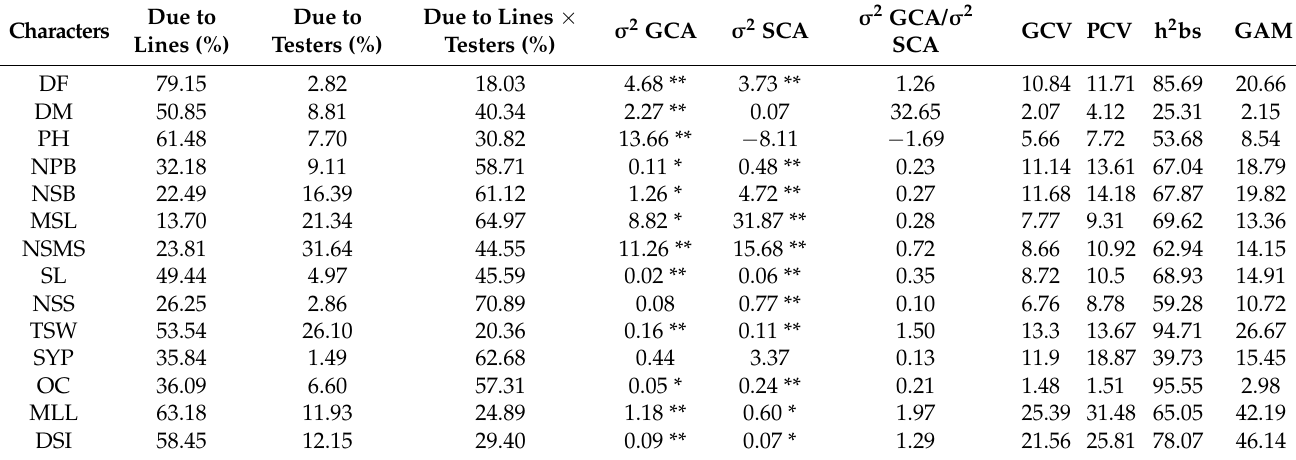
Table 6. Contribution of lines, testers, and their interaction to the total variance; GCA, SCA, and GCA/SCA variance, genotypic coefficient of variation (GCV), phenotypic coefficient of variation (PCV), broad sense heritability (h 2 bs), and genetic advance as per cent of mean (GAM)for seed yield and its component traits and Sclerotinia stem rot resistance in Indian